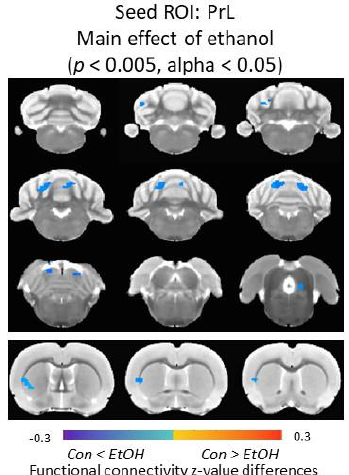
Figure 7. Alterations of PrL functional connectivity in male rats. Main effect of ethanol was detected in insular/striatum area, the external cortex of the inferior colliculus and cerebellar areas. Color code: connectivity differences between Control (Con) and Ethanol (EtOH) animals. ROI=Region of Interest, PrL=Prelimbic Cortex.